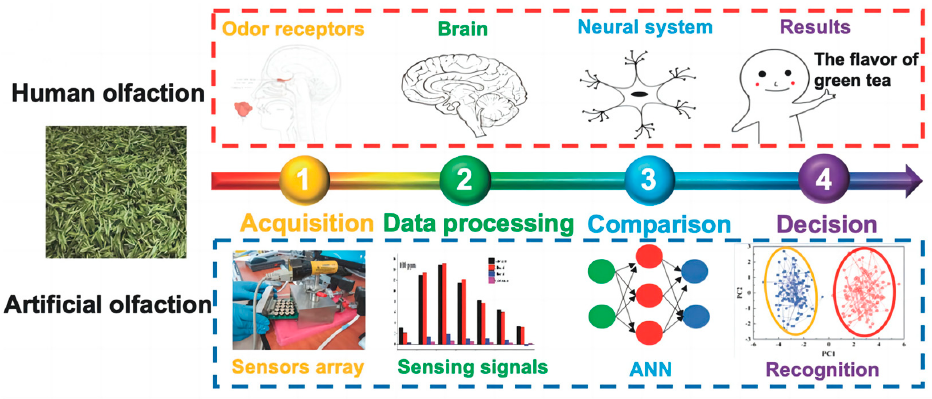
Figure 1. Schematic diagram of the human olfaction and e − nose system in 2022